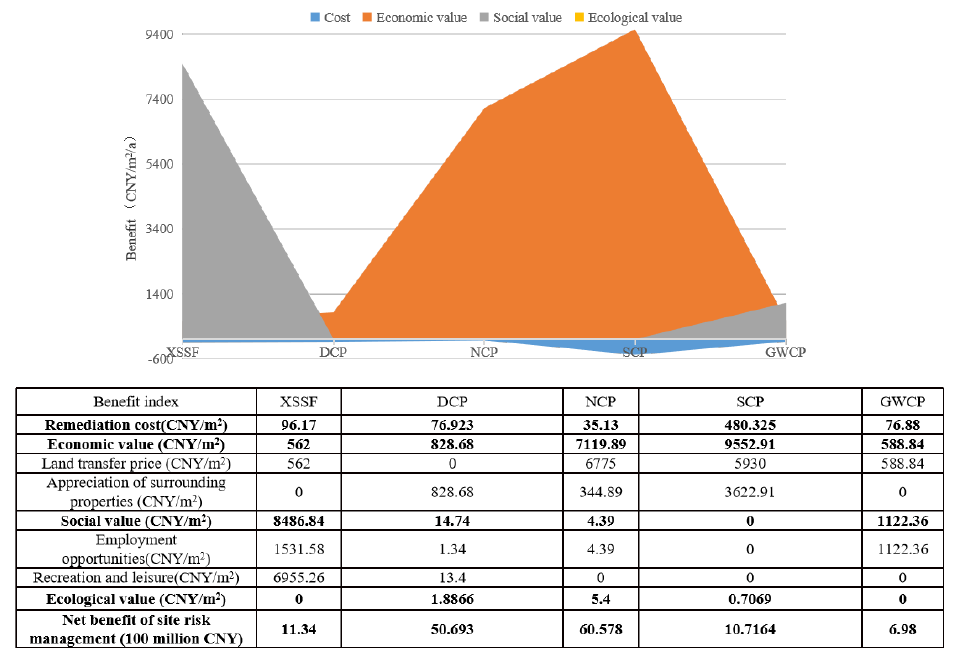
Figure 3. The results of the benefit assessment of the contaminated